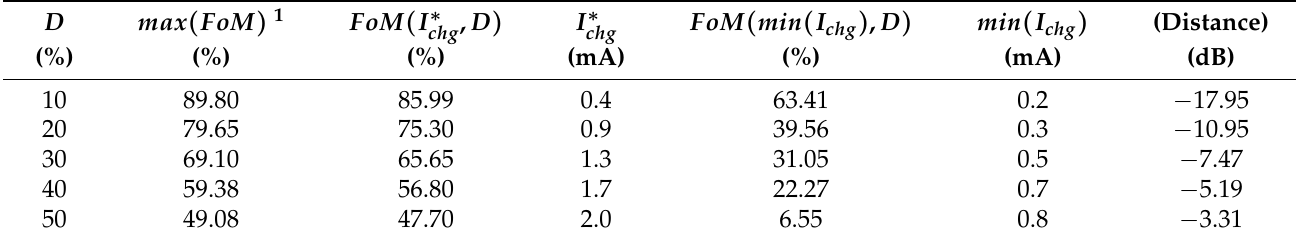
Table 2. Critical design points from the Pareto front for minimum charging current and high/low charging